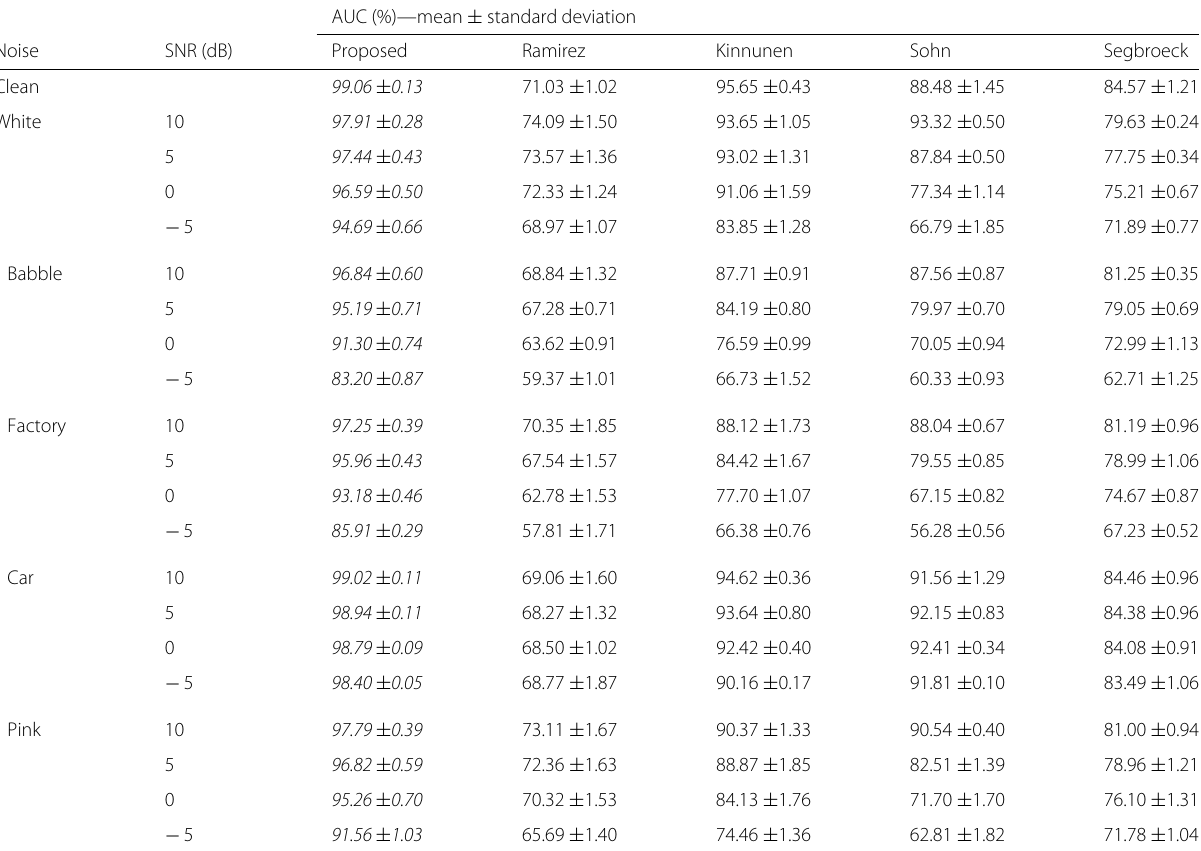
Table 5 AUC (%) comparison between the proposed method and other methods (Ramirez et al. [8], Kinnunen et al. [11], Sohn et al. [12], and Segbroeck et al.